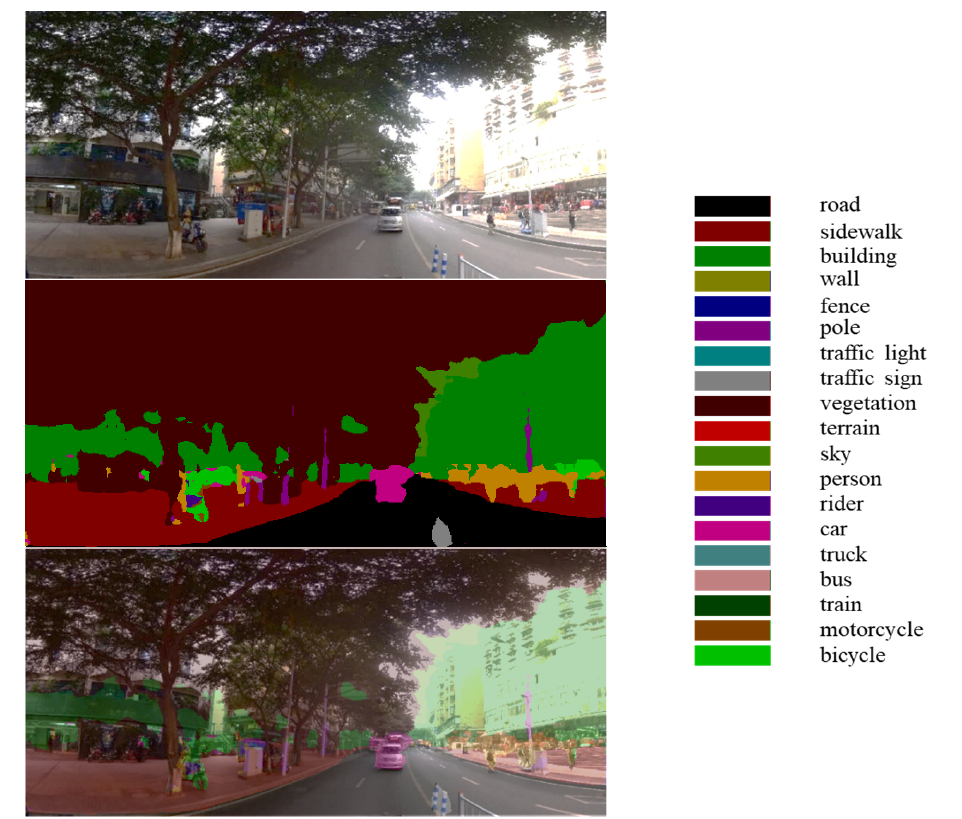
Figure 3. Statistics of the number of classified POIs.